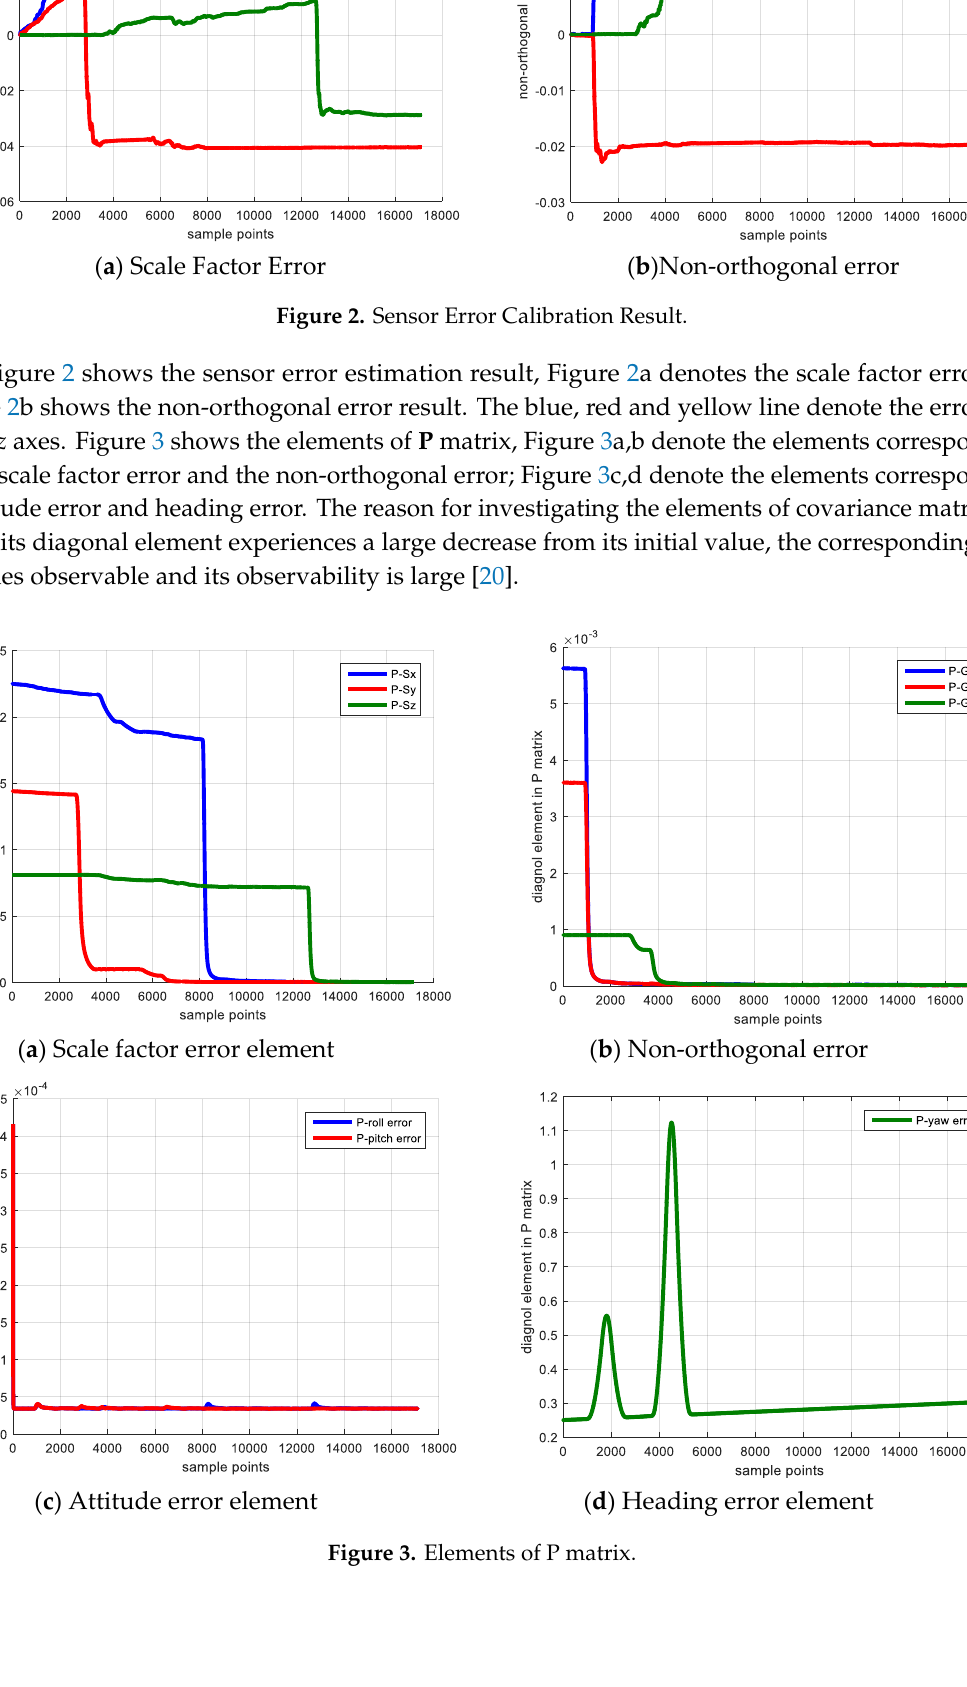
Table 8. Bias Calibration Result. Bias Error